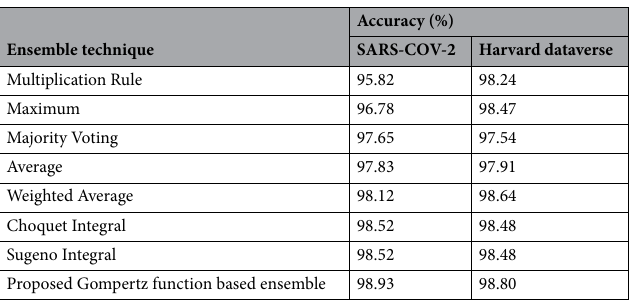
Table 6. Comparison of popular ensemble techniques with the proposed Gompertz function based ensemble method.